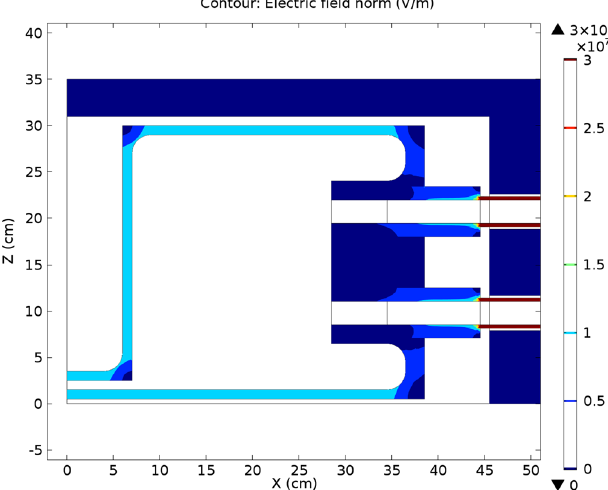
FIG. 12. Contour plot of electric field in cable header-DI water line region.